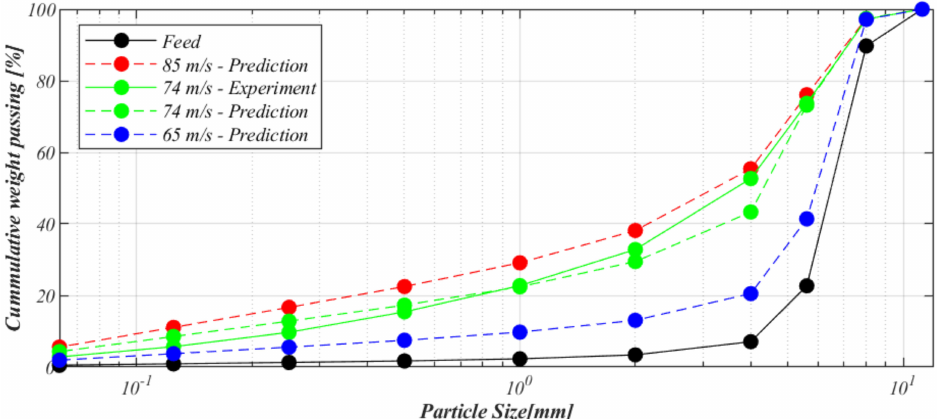
Figure 9. Particle size distributions from one of the sites and the corresponding simulation results for speeds exceeding the training data of the model. Note that the training speeds were still 69 and 79 m/s, not shown in the